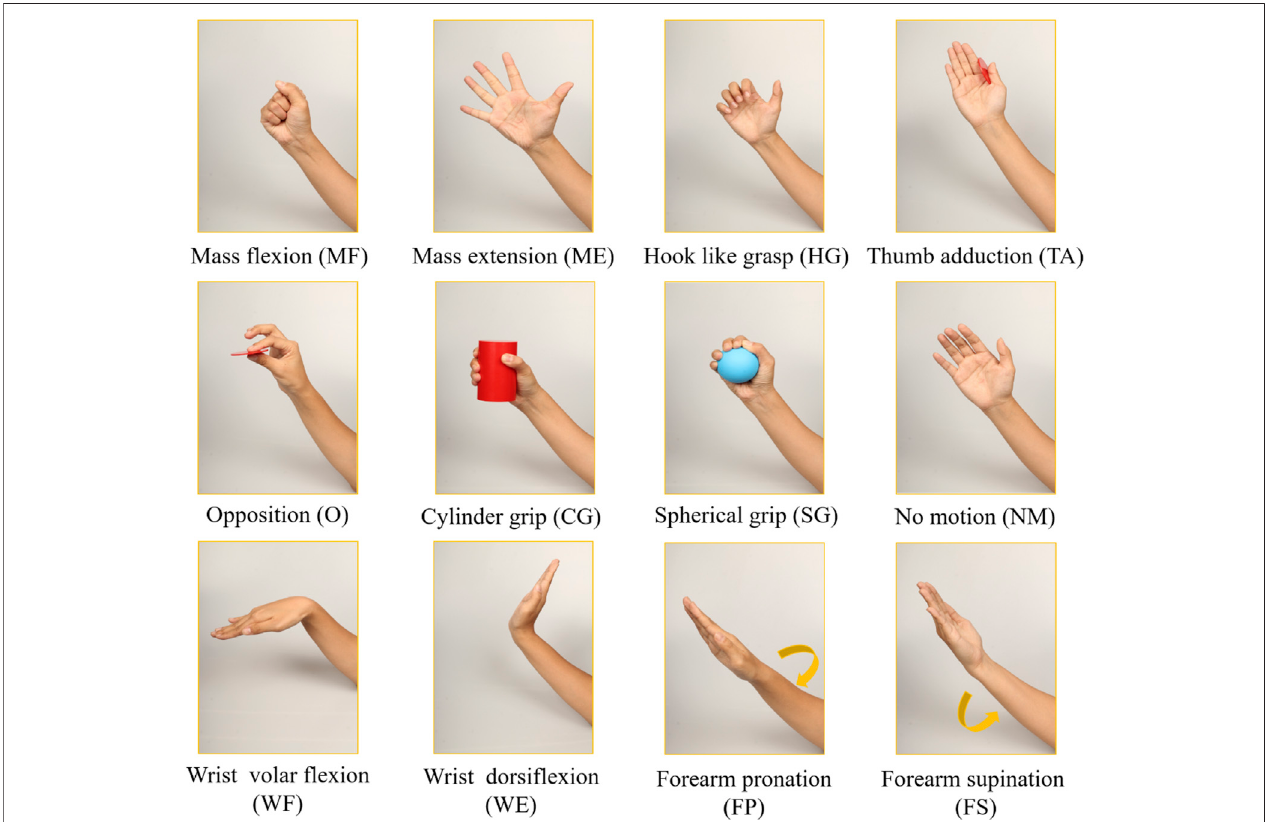
FIGURE 3 | Example stroke patient playing a serious game while wearing the wearable multimodal-based system.